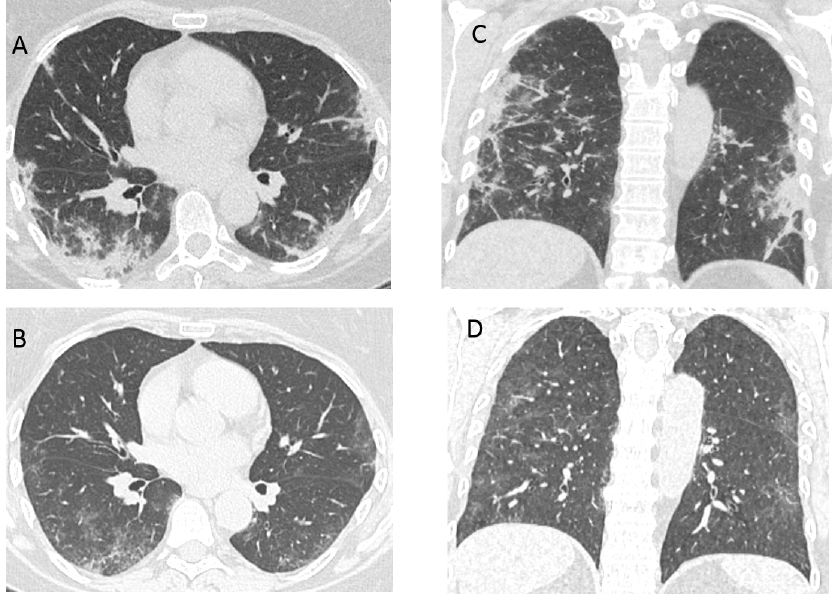
Figure 1. ( A , C ) Computed tomography (CT) of a 58-year-old woman, 21 days after COVID-19 pneumonia diagnosis, treated at home, with persistent and deteriorating respiratory symptoms. Peripheral consolidation with air bronchograms, reticular changes and small areas of ground glass opacities (organizing pneumonia). ( B , D ) CT after 4 weeks of treatment with systemic glucocorticoids—resorption of consolidation with the fibrotic component (reticular changes, bronchiectasis).